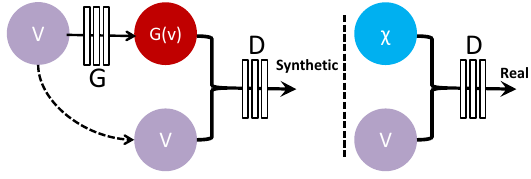
Figure 4. Multi-face